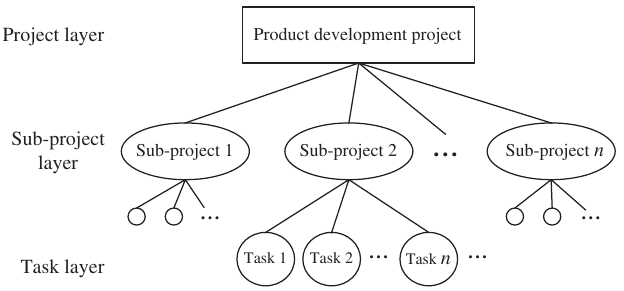
Figure 1: Task Decomposition According to the Way of